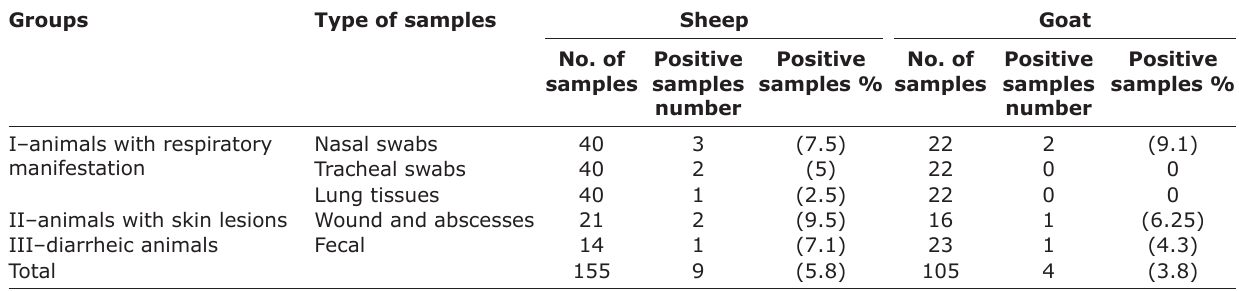
Table-3: Prevalence of Pseudomonas aeruginosa recovered from living and slaughtered sheep and goat. Groups